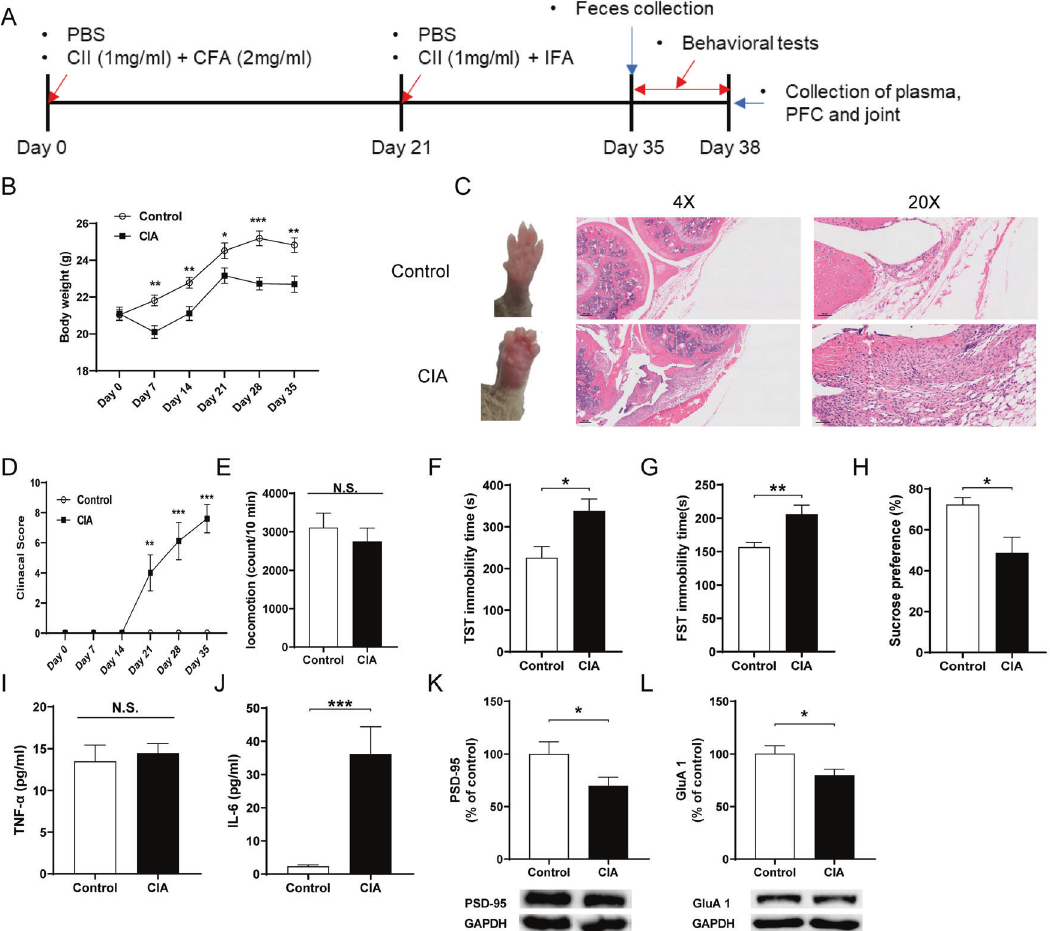
Fig. 1 Joint swelling and depression-like phenotypes after collagen-induced arthritis. A Schedule of treatment, behavioral tests and sample collection. B Body weight among two groups (repeated measure one-way ANOVA, F 1,18 = 22.988. P < 0.001). C Representative images of wrist joint and representative H&E staining on the knee joint. D Clinical score (repeated measure one-way ANOVA, F 1,18 = 34.892. P < 0.001). E Locomotion test (LMT) (Student t -test: t = 0.701, P = 0.492). F TST (Student t -test: t = − 2.843, P = 0.011). G FST (Student t -test: t = − 3.225, P = 0.005). H SPT (Student t -test: t = 2.831, P = 0.011). I Plasma TNF- α levels (Student t -test: t = − 0.446, P = 0.661). J Plasma IL-6 levels (Student t -test: t = − 4.127, P < 0.001). K PSD-95 (Student t -test: t = 2.138, P = 0.046). L GluA1 (Student t -test: t = 2.204, P = 0.045). Data are shown as mean ± S.E.M. ( n = 10). * P < 0.05, ** P < 0.01, *** P <